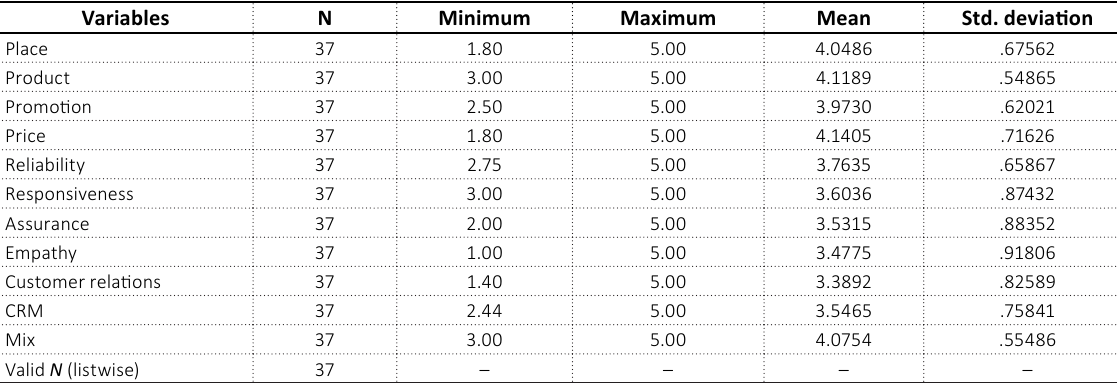
Table 4. Descriptive statistics of study